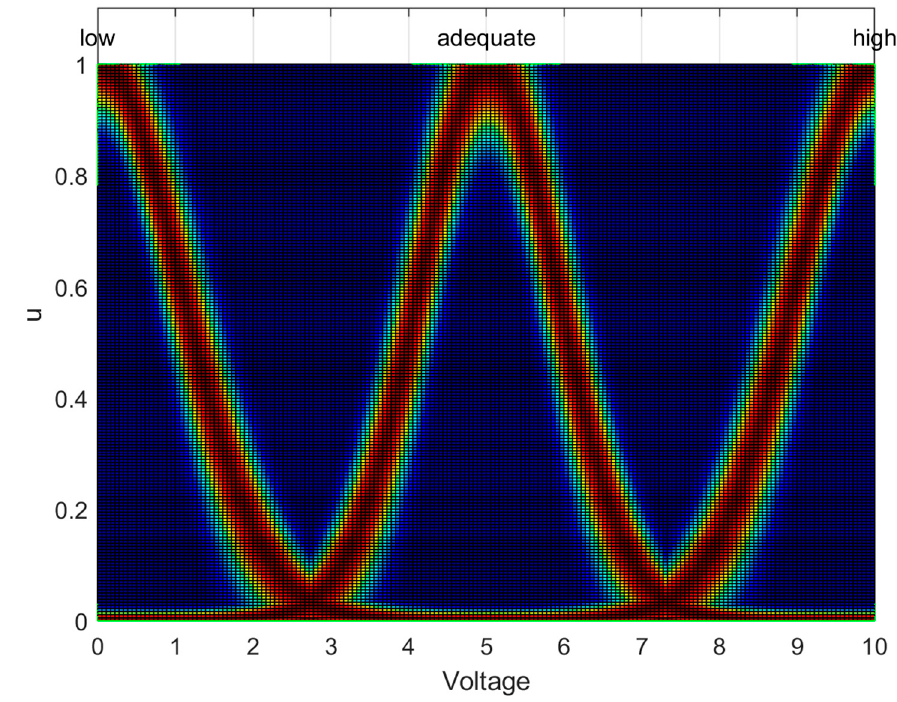
Figure 8. Input MFs of the electric voltage variable.